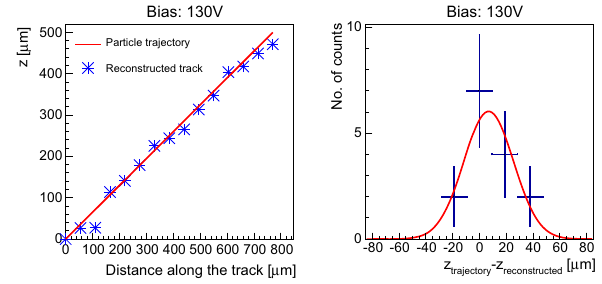
Fig. 7 Comparison of the reconstructed z i , rec . and “real” z -coordinate (obtained from the interpolation of entry and exit point) for a single track. The bias was